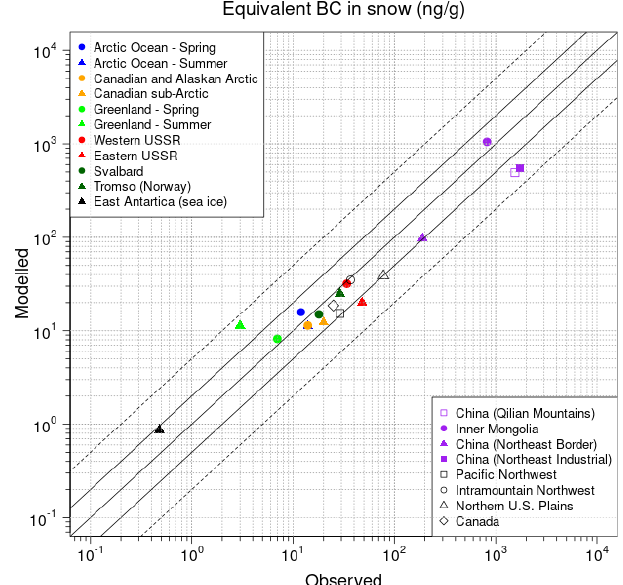
Figure 1. Scatterplots of the observed and modeled BC mixing ratio in the snow. The central continue line is the 1:1 line; other continue lines correspond to 1:2 and 2:1 lines. Dotted lines correspond to 1:5 and 5:1 lines.